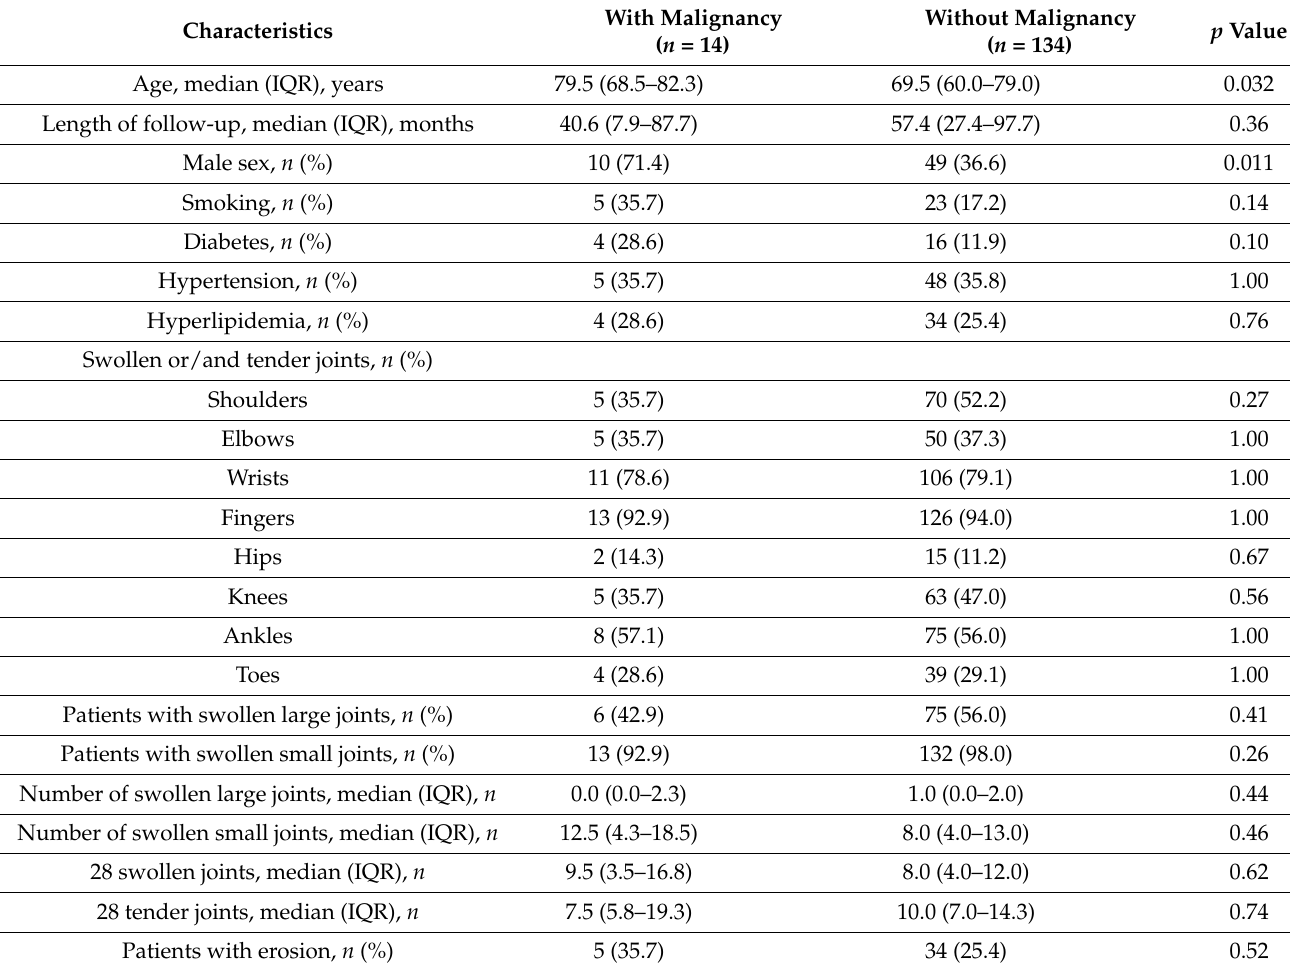
Table 4. Patient baseline characteristics at diagnosis of RS3PE and seronegative RA patients with or without malignancies. With Characteristics